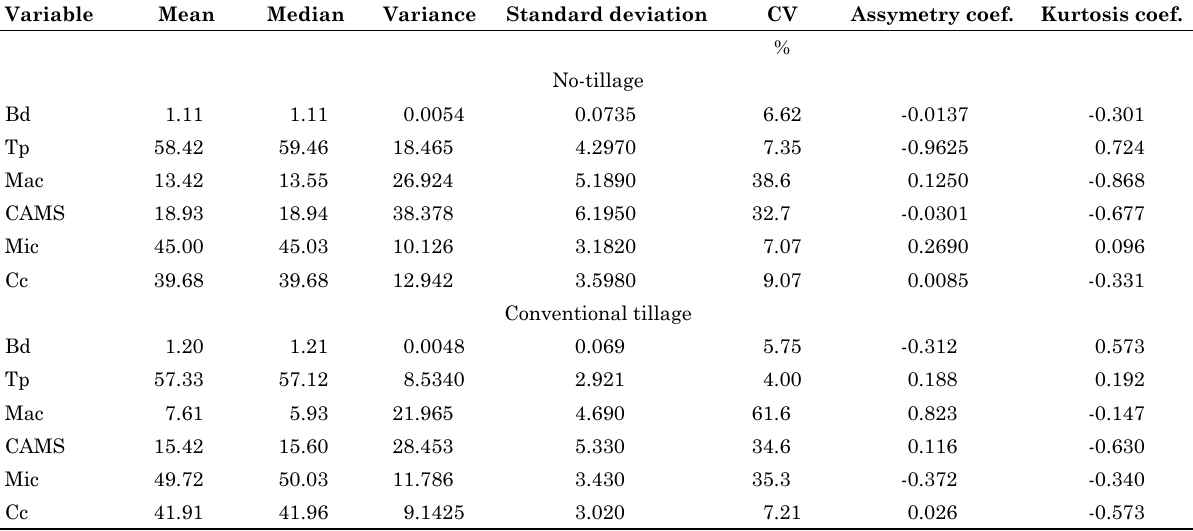
Table 1. Statistics describing the variables of soil properties evaluated in the two studied management